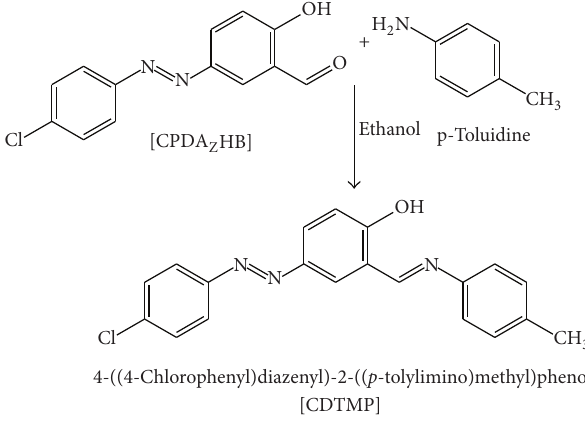
S 1: Synthesis of azo Schiff base